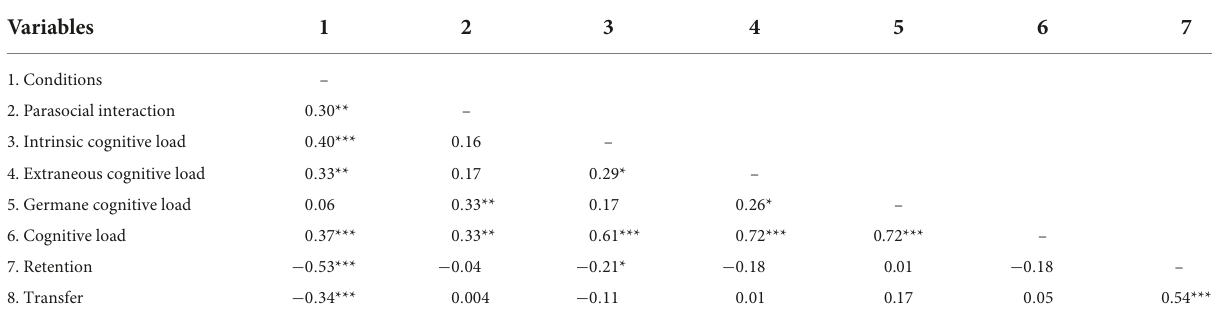
TABLE 3 Pearson correlations for research